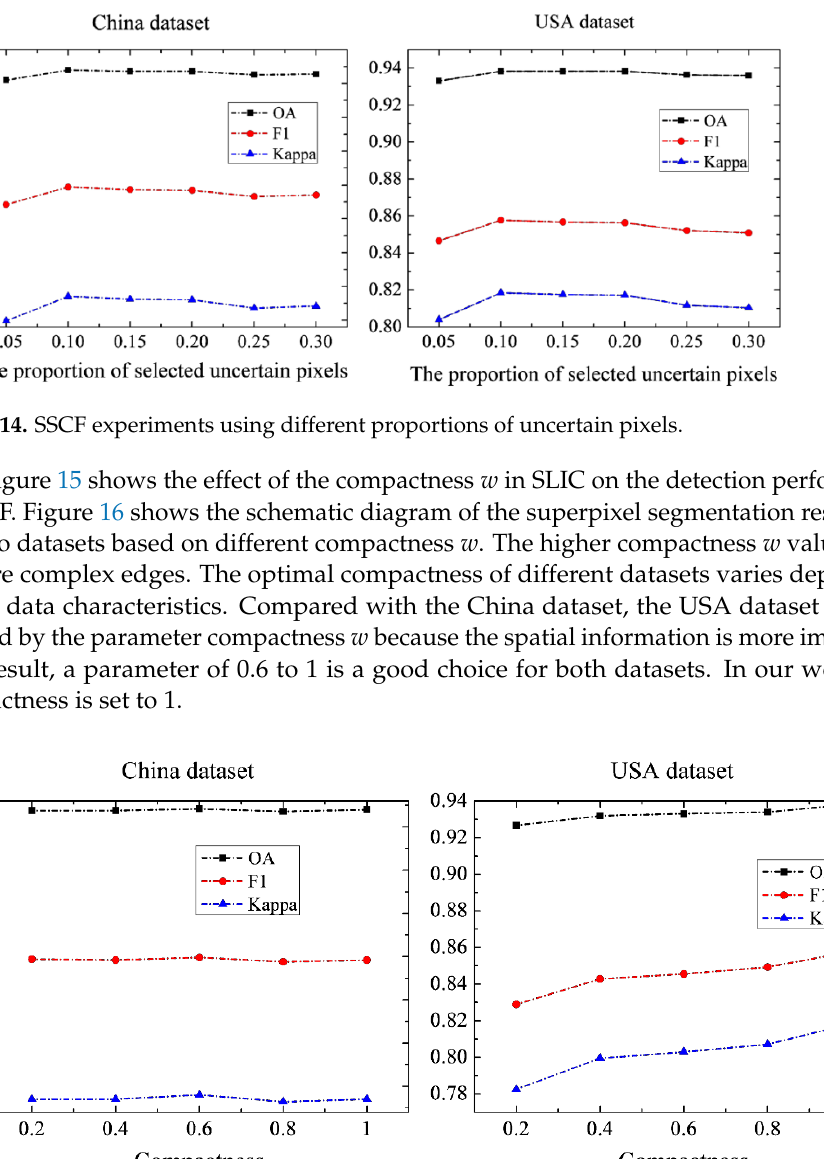
Figure 15. SSCF experiments using different compactness w .